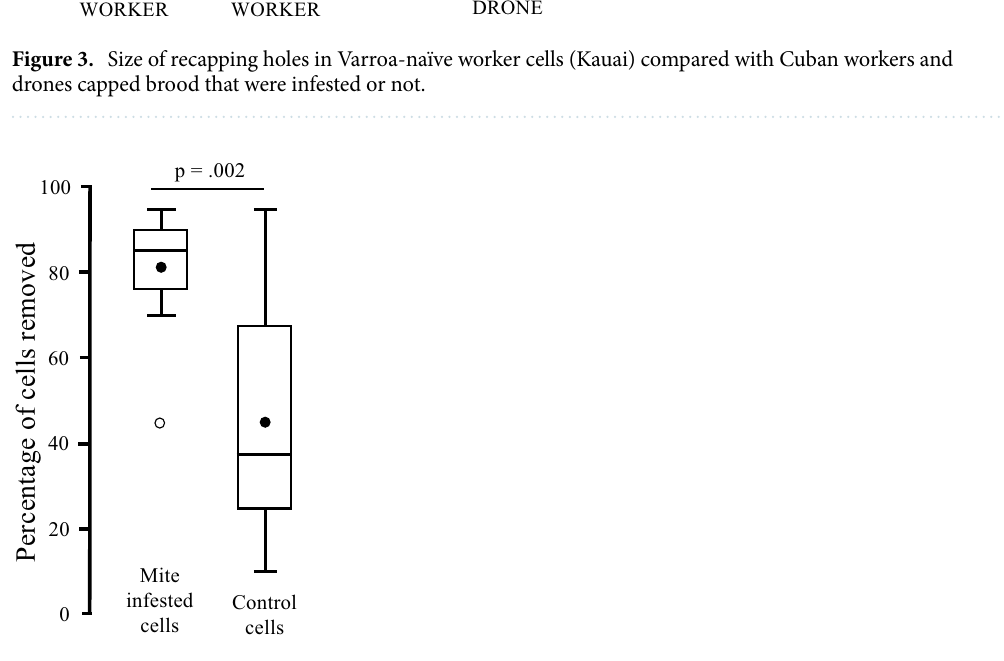
Figure 4. Percentage of removal in mite infested and control cells indicating the significant difference between the two groups and showing a large inter-colony variation among the control cells, relative to the mite infested cells.